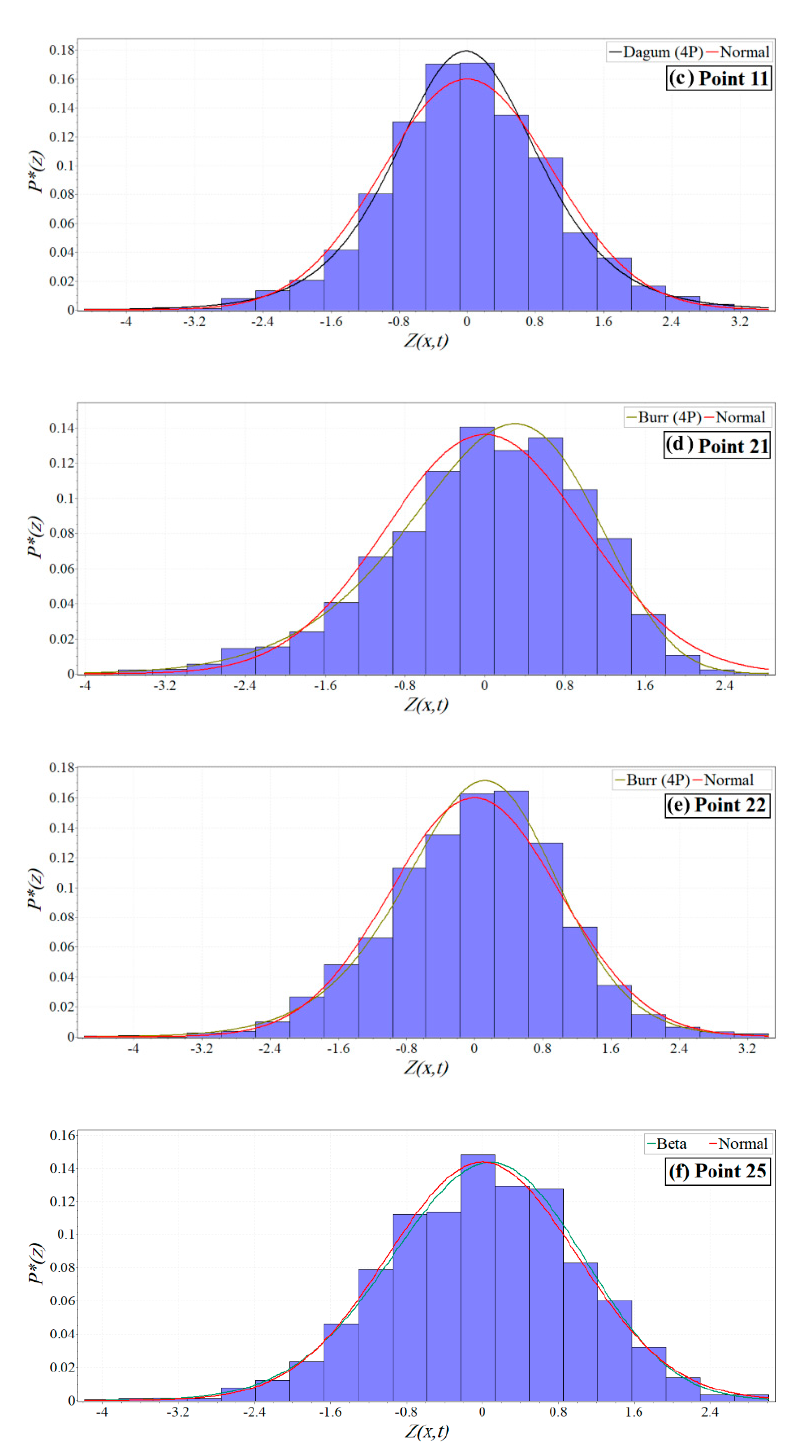
Figure 5. Probability density function (PDF) histograms of fluctuating pressures at some points of basin II (Fr 1 = 6.14): ( a ) point 1; ( b ) point 8; ( c ) point 11; ( d ) point 21; ( e ) point 22; ( f ) point 25.